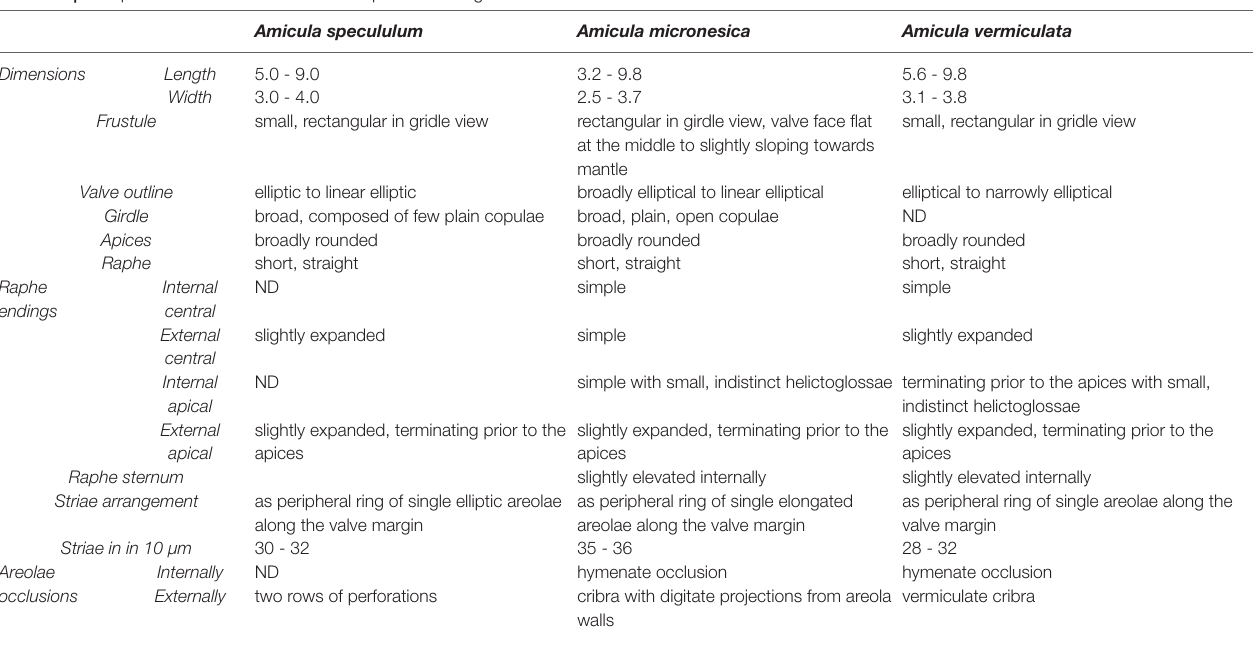
TABLE 1 | Comparison table between the three species of the genus Amicula .